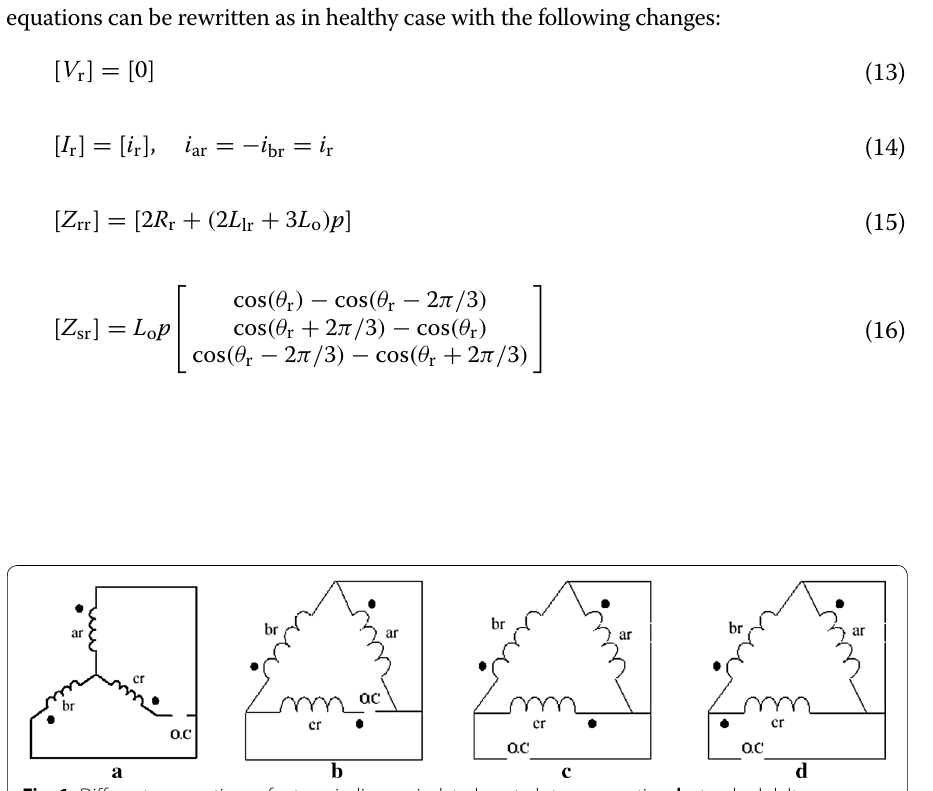
Fig. 1 Different connections of rotor windings: a isolated neutral star connection, b standard delta connection with internal open circuit, c standard delta connection with external open circuit and d delta connection with reversed one phase and external open